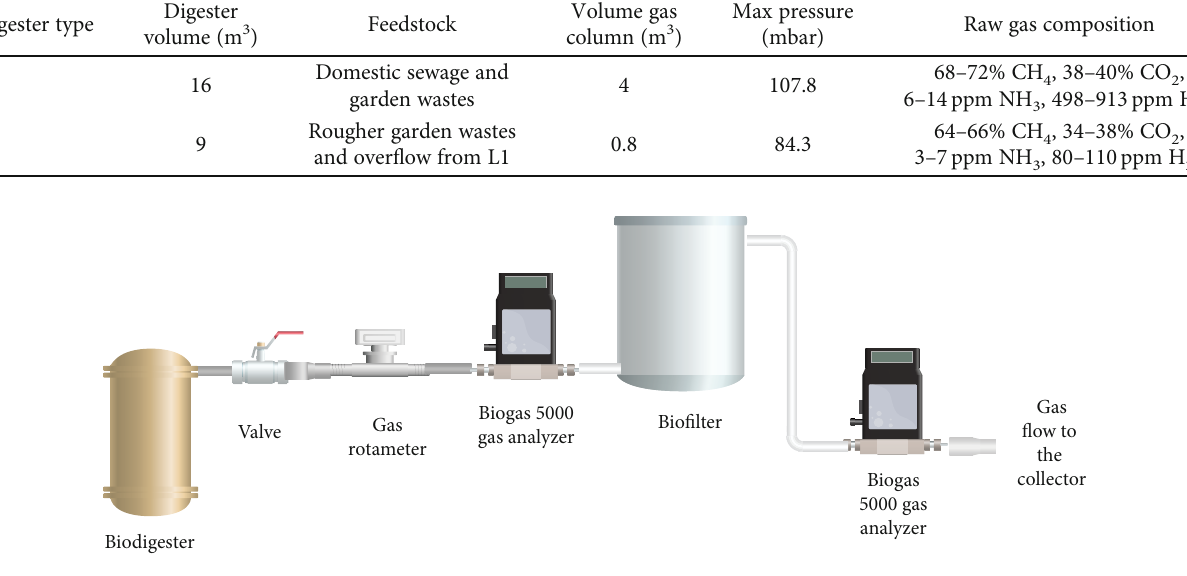
Figure 2: Photo and schematic diagram of the experimental setup.